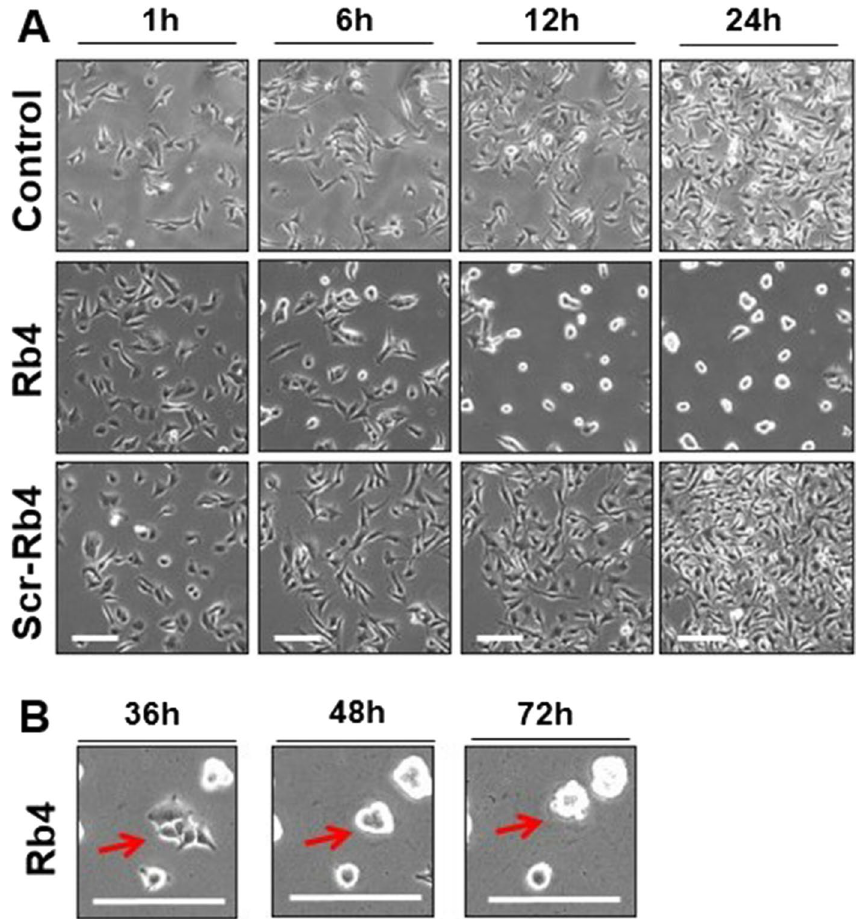
Figure 1. Time-lapse phase images of melanoma B16F10-Nex2 cells treated with Rb4 and Scr-Rb4. ( A ) Panels are representative fields of B16F10-Nex2 cells after control, Rb4 or Scr-Rb4 treatment for 1, 6, 12 and 24 h of incubation. Loss of morphology and no replication was observed for Rb4-treated cells. ( B ) Representative panels of B16F10-Nex2 cells treated with Rb4 for 36, 48 and 72 h showing resistant cells, highlighted in red, losing morphology and clustered after prolonged exposure to Rb4 peptide. Bar, 200 µm. See Supplementary material for full time-lapse